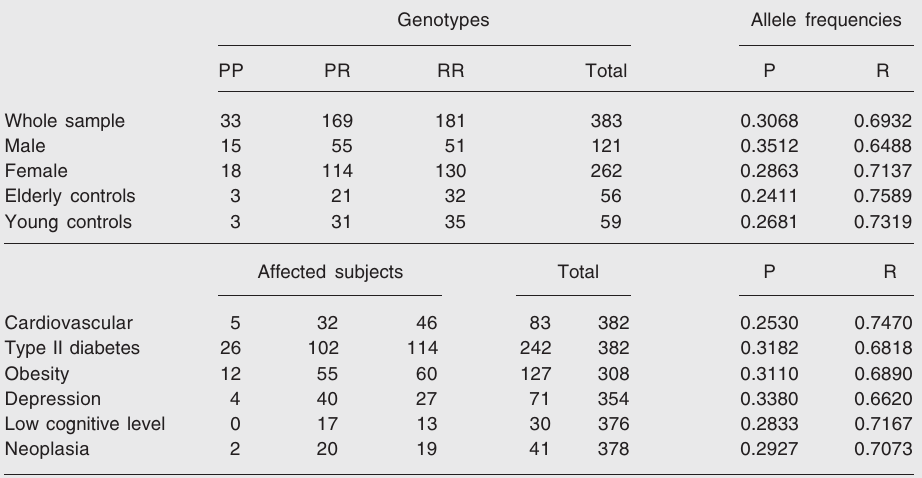
Table 1. Number and distribution of TP53:72 genotypes and alleles in a Brazilian elderly cohort and in elderly and young healthy controls.